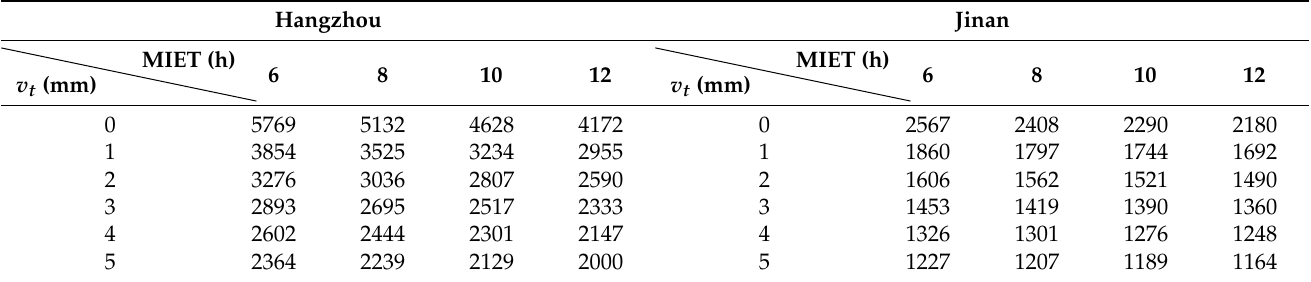
Table 2. Total number of rainfall events with different pairs of MIET and v t for Jinan and Hangzhou. Hangzhou Jinan